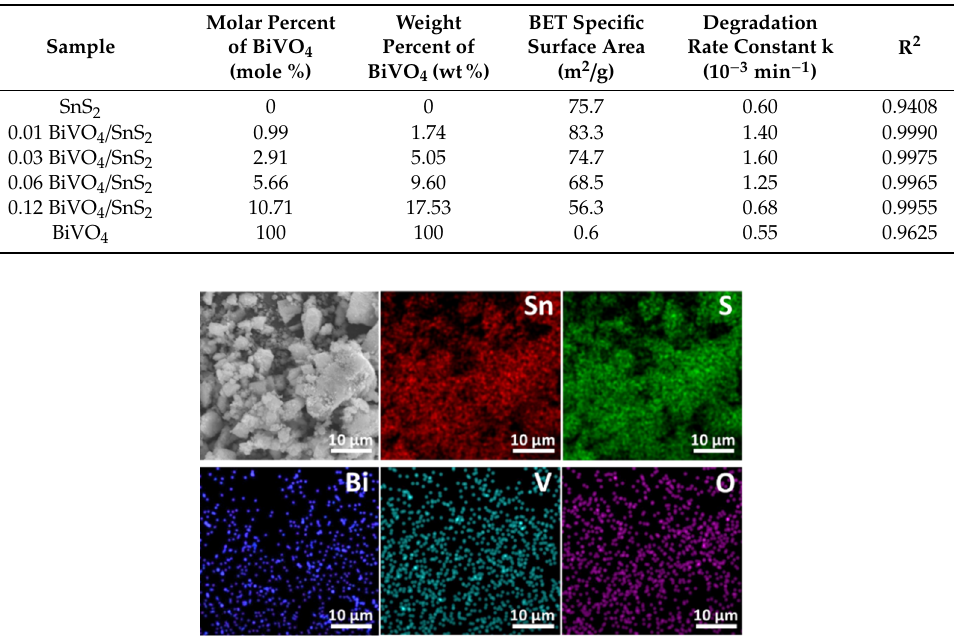
Figure 3. EDS elemental mapping of Sn, S, Bi, V, and O elements in 0.03 BiVO 4 /SnS 2 . Table 1. Comparison of molar/weight percent BiVO 4 , specific surface area, and pseudo-first-order-kinetic degradation constant, for SnS 2 , BiVO 4 , and BiVO 4 /SnS 2 composites with various BiVO 4 -to-SnS 2 ratios.